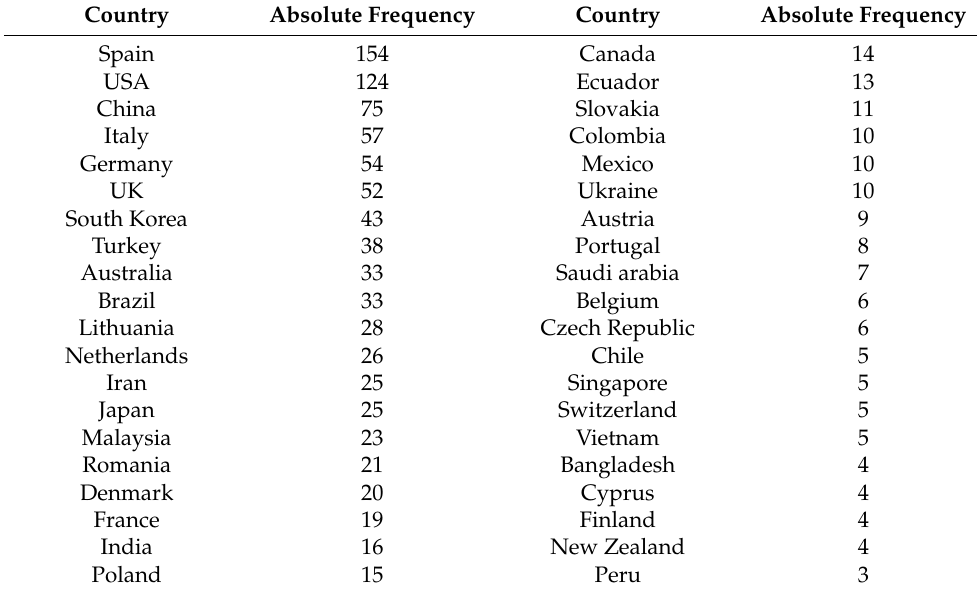
Table 3. Top twenty countries in neuromarketing research productivity.